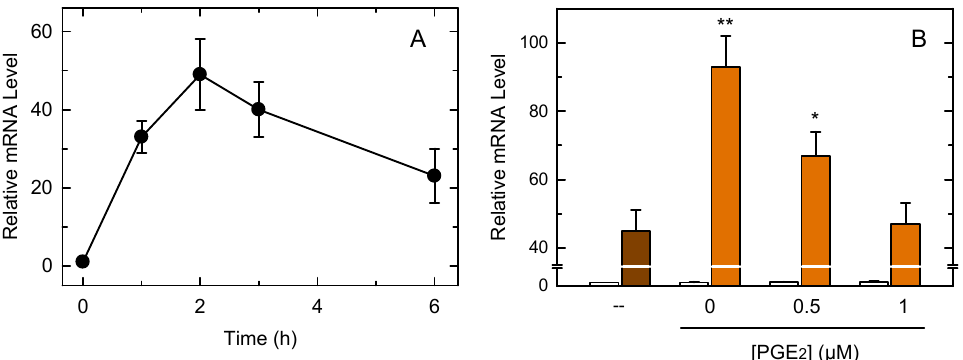
Figure 5. Analysis of Tnf expression in macrophages. ( A ) The cells were treated with 1 mg/mL zymosan for different periods of time. Afterward, Tnf expression was studied by qPCR. ( B ) The cells were stimulated with zymosan in the absence (brown bar) or presence (orange bars) of 20 µ M aspirin plus the indicated concentrations of PGE 2 . Open bars denote incubations in the absence of zymosan. After the 1-h incubations, Tnf expression was studied by qPCR. The results, are shown as means ± standard error (n = 6). ** p < 0.01 or * p < 0.05, significance of incubations in the presence of aspirin versus incubations in the absence of aspirin.